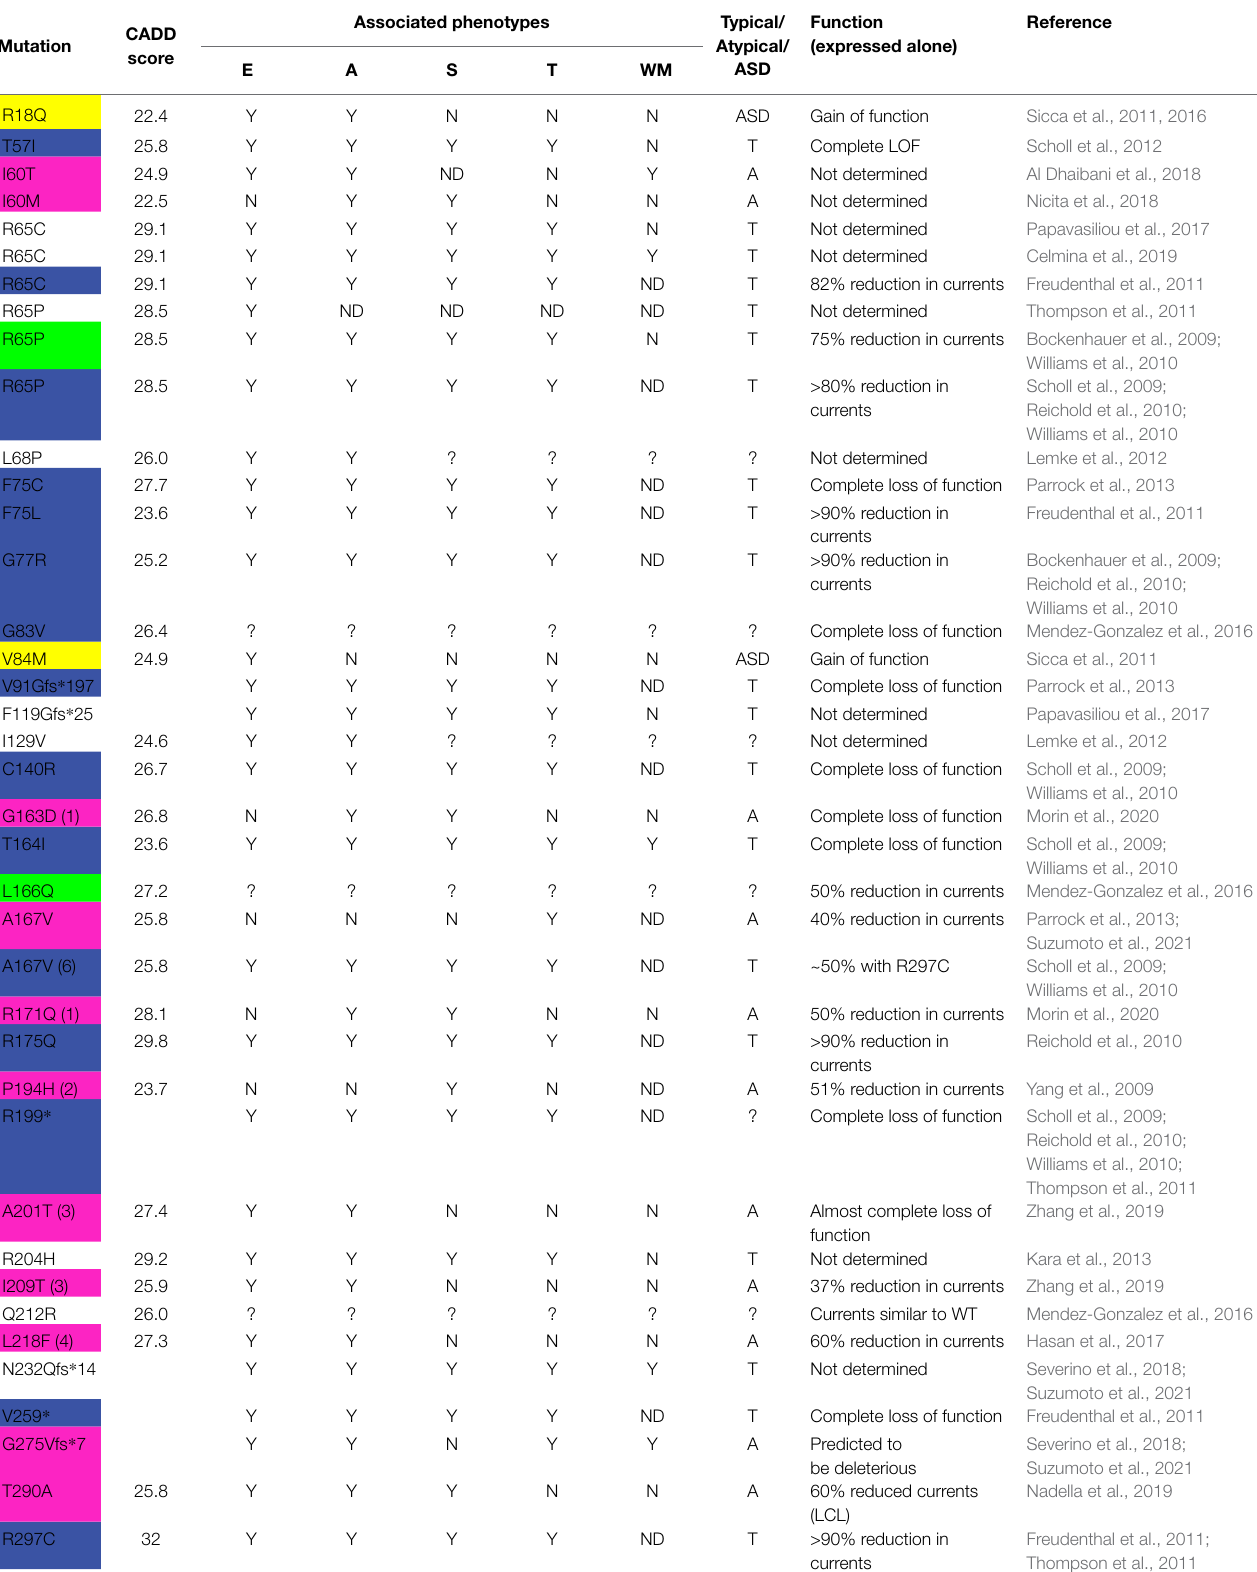
TABLE 1 | Mutations identified in KCNJ10